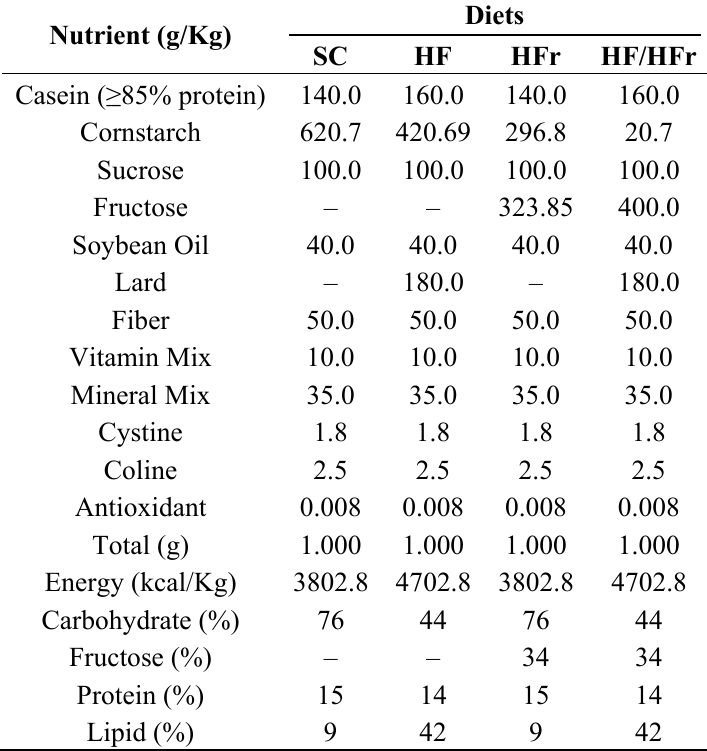
Table 2. Diet Composition. Groups: SC, HF, HFr,